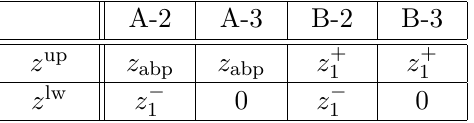
are defined in eqs. (A.12) and (A.17), 1